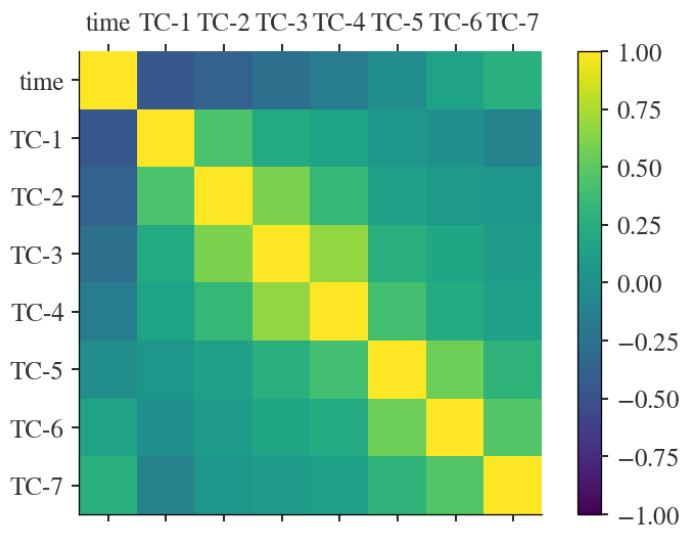
Figure 13. Correlation matrix temperature plot.